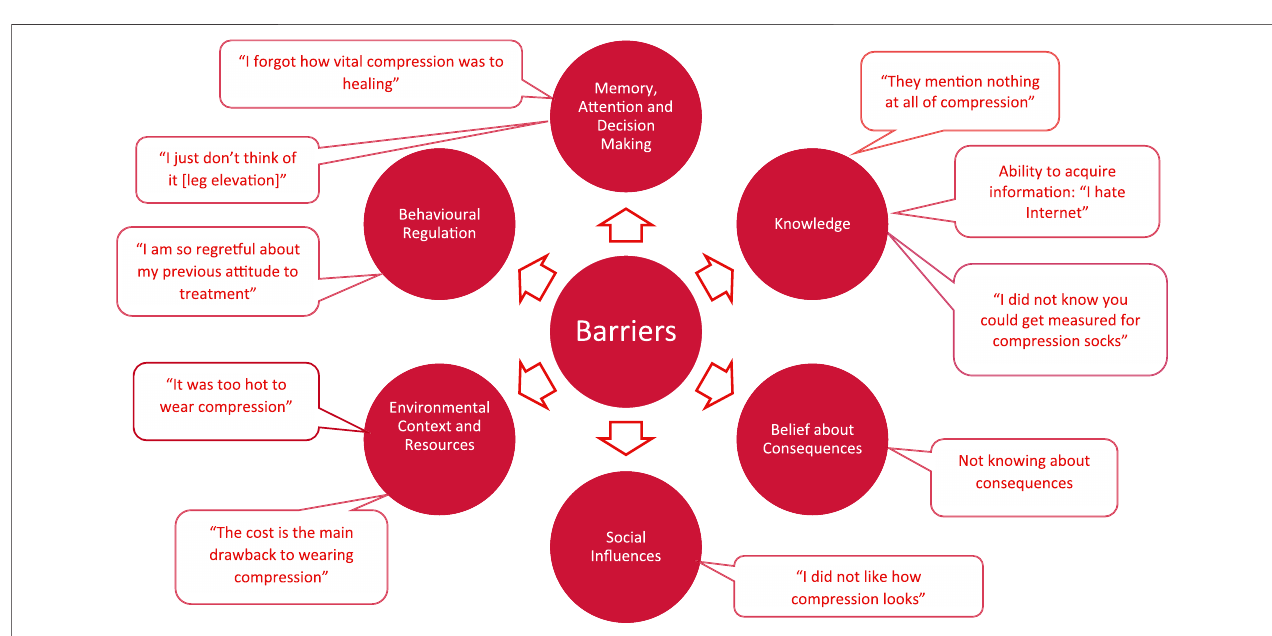
FIGURE 2 | Barriers to patients ’ adherence to the venous leg ulcer treatment recommendations.